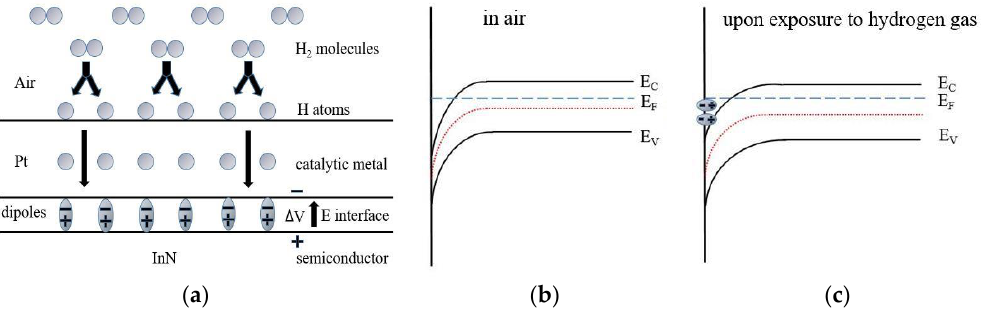
Figure 4. A schematic diagram of hydrogen adsorption process. ( a ) Formation of a dipole layer, formed by hydrogen atoms trapped at the interface of catalytic metal and semiconductor, causing a voltage shift. ( b ) The corresponding schematic energy band diagram of the studied device ( b ) at air and ( c ) under the introduction of hydrogen gas.